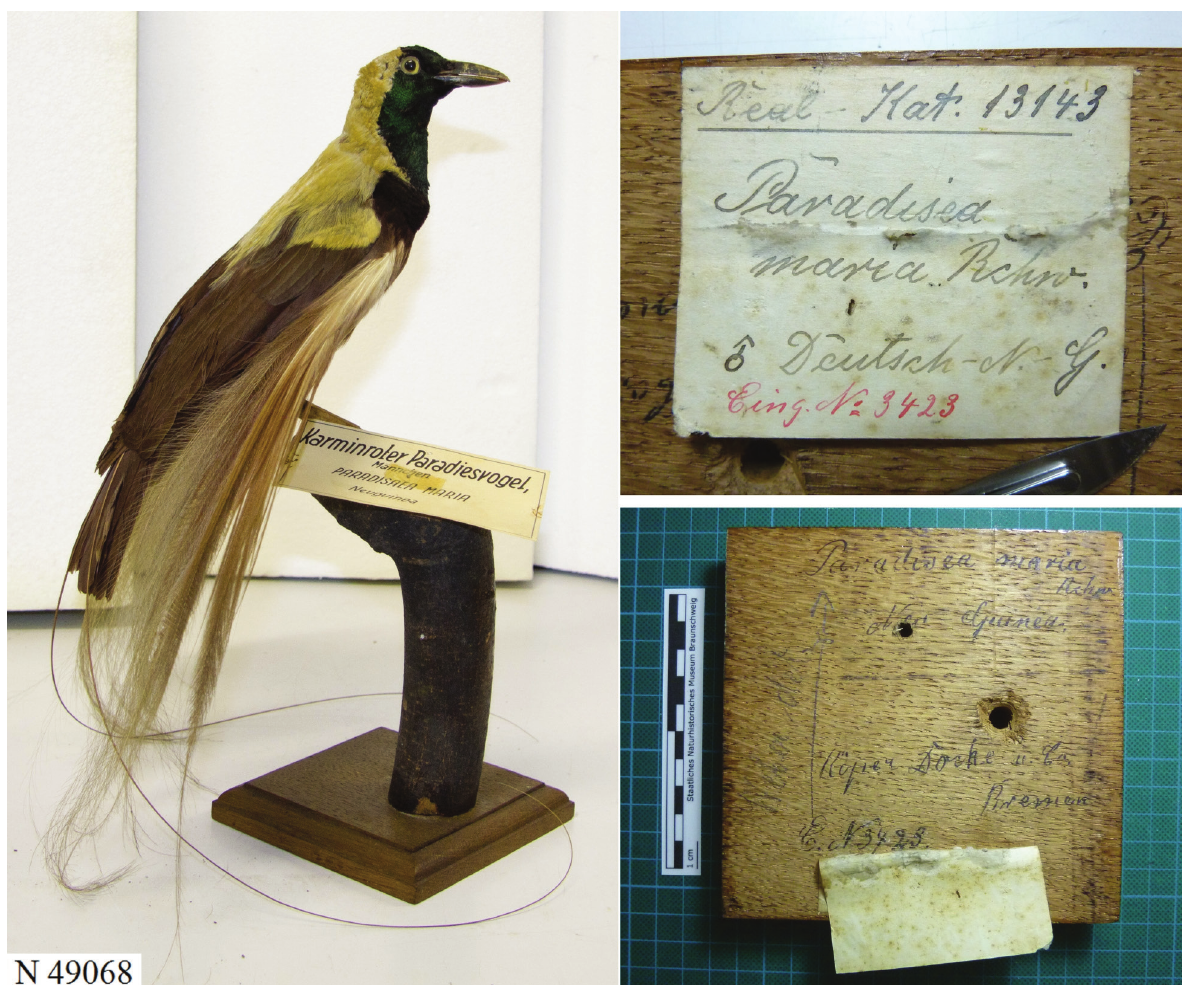
Figure 4. The male specimen SNMB N49068 of P. maria in the Staatliches Naturhistorisches Museum in Braunschweig. The in- formation written on the underside of the pedestal in black ink is as follows: “ Paradisea maria R[ei]ch[eno]w. Neu-Guinea [= New Guinea] Köper Docke u. Co. Bremen C. N. 3423. Weber [?] det. [?]”. The white label written with pencil, which partly sticks above the former ink writing, reads as follows: “Real. Kat. 13143 Paradisea maria Rchw. ♂ Deutsch-N.-G. Eing. N° 3423” (= Realia Catalogue No. 13143, Paradisea maria Reichenow, ♂, German New Guinea, Entrance No. 3423). Photos by M.